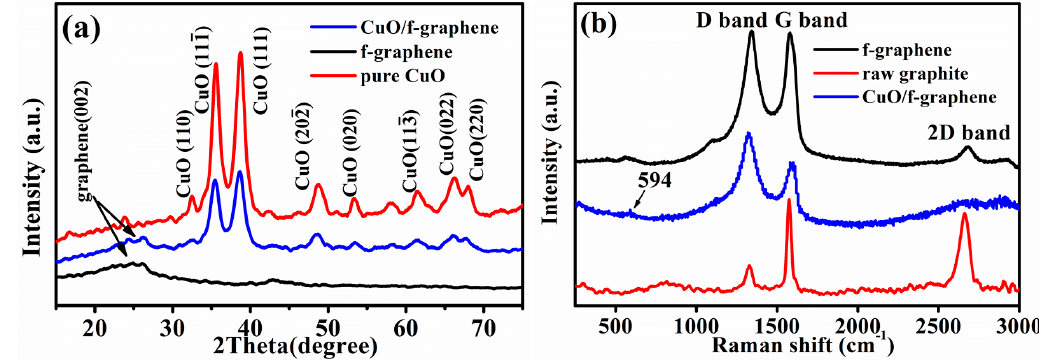
Figure 1. ( a ) XRD patterns of the f-graphene, pure CuO, and the CuO/f-graphene composite; and ( b ) Raman spectra of raw graphite, the f-graphene, and the CuO/f-graphene composite.